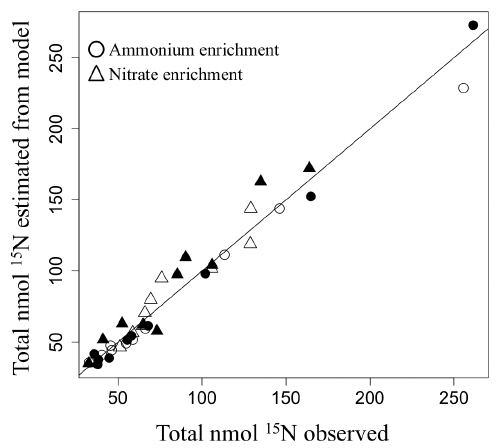
Figure 4. The relationship between the predicted total 15 N (in nmolL − 1 ) (by the ODE model) and observed quantity of total 15 N (in nmolL − 1 ) at the end of each of the 15 NH 4 and 15 NO 3 tracer experiments. The 1 : 1 line is shown and indicates that the model did not, on average, lead to an artificial production or loss of 15 N and thus provided a reasonable fit to overall 15 N dynamics. Each estimate is per tidepool and filled symbols are night, while unfilled symbols are day.